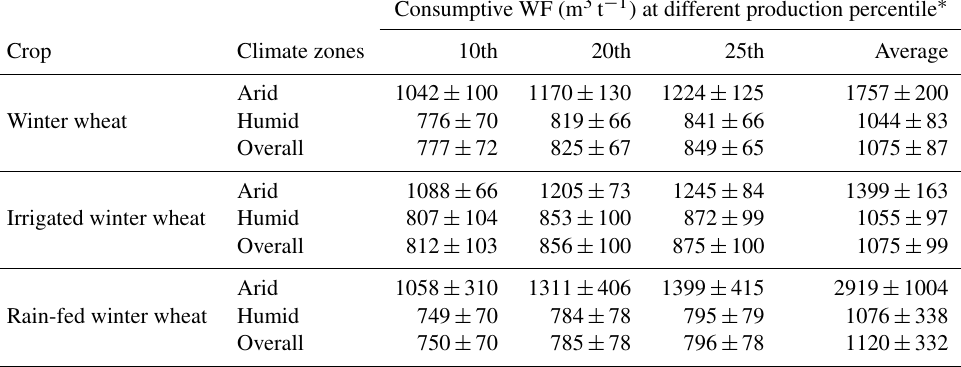
Table 6. Benchmarks for the consumptive water footprint (WF) (m 3 t − 1 ) of winter wheat for different climate zones in